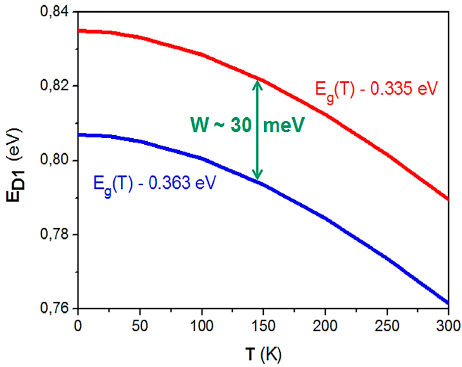
Figure 22. Domain of D1-line extracted from experimental data. To the best of our knowledge, most of the reported D1 positions fall into this 30 meV wide domain [113].